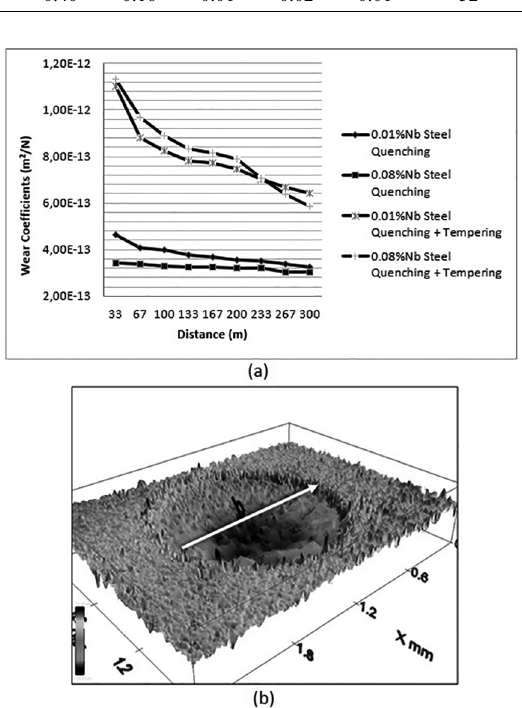
Figure 1. Wear coefficients of steels after quenching at 900 ºC and quenching at 900 ºC plus tempering at 600 ºC (a) and wear crater in the specimen surface of the steel (b). The arrow indicates the crater size after the test